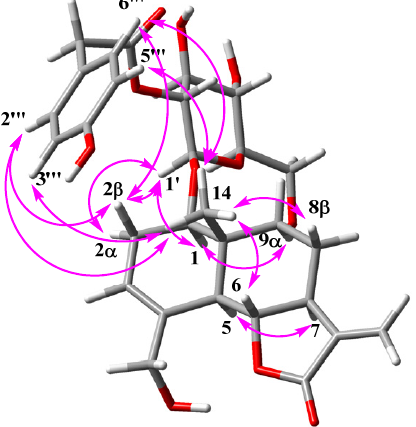
Figure 2. Key ROE correlations of 4 .